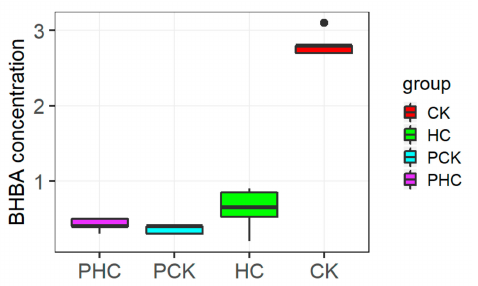
Figure 2. The measured β -hydroxybutyrate (BHBA) values among di ff erent